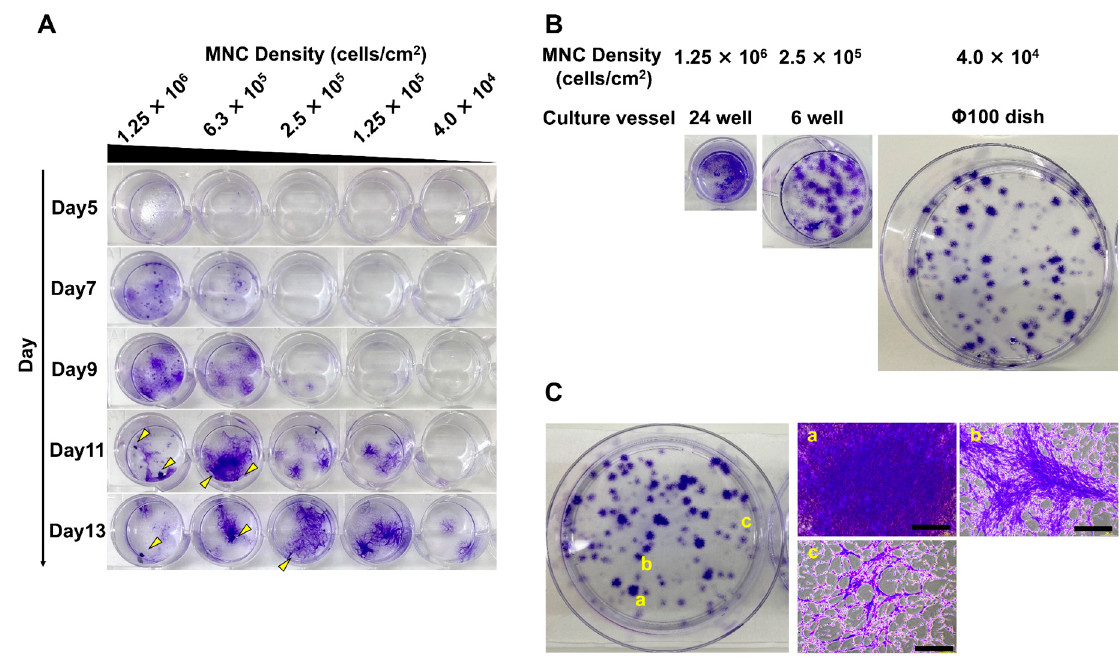
Figure 1. Timing of densification, distribution, and morphology of mesenchymal stem cell (MSC) colonies varied with different seeding densities of mononuclear cells (MNCs). ( A ) MNCs were cultured at various seeding densities (4.0 × 10 4 , 1.25 × 10 5 , 2.5 × 10 5 , 6.3 × 10 5 , and 1.25 × 10 6 cells/cm 2 ). MSC colonies were stained with crystal violet over time. Arrowheads indicate aggregated cells. ( B ) A fixed number of MNCs was seeded into culture vessels of different culture areas (24-well plate, 6-well plate, 100 mm dish), and cultured. Colonies were stained with crystal violet. ( C ) The pattern of colonies formed under the low MNC seeding density condition (4.0 × 10 4 cells/cm 2 ). The scale bar